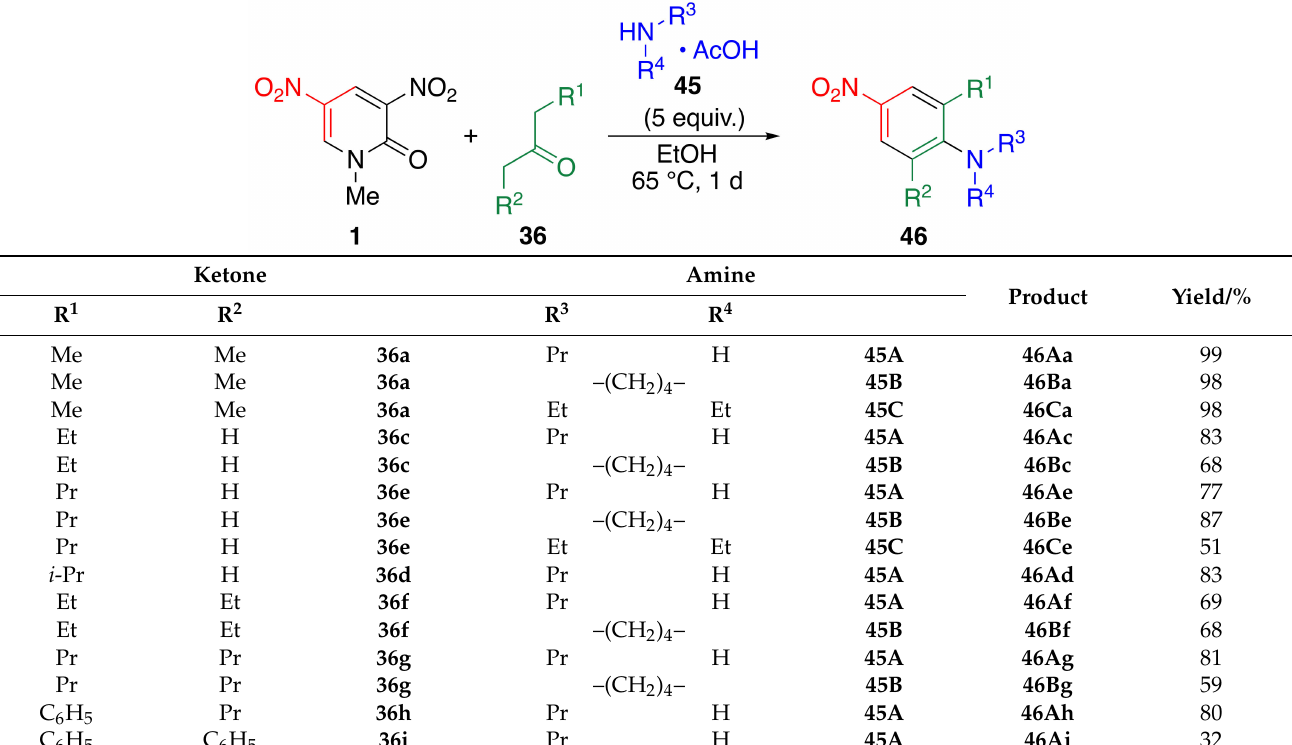
Table 10. Synthesis of N,N ,2,6-tetrasubstituted 4-nitroanilines 46 by TCRT using aliphatic ketones 36 and dialkylammonium acetate 45